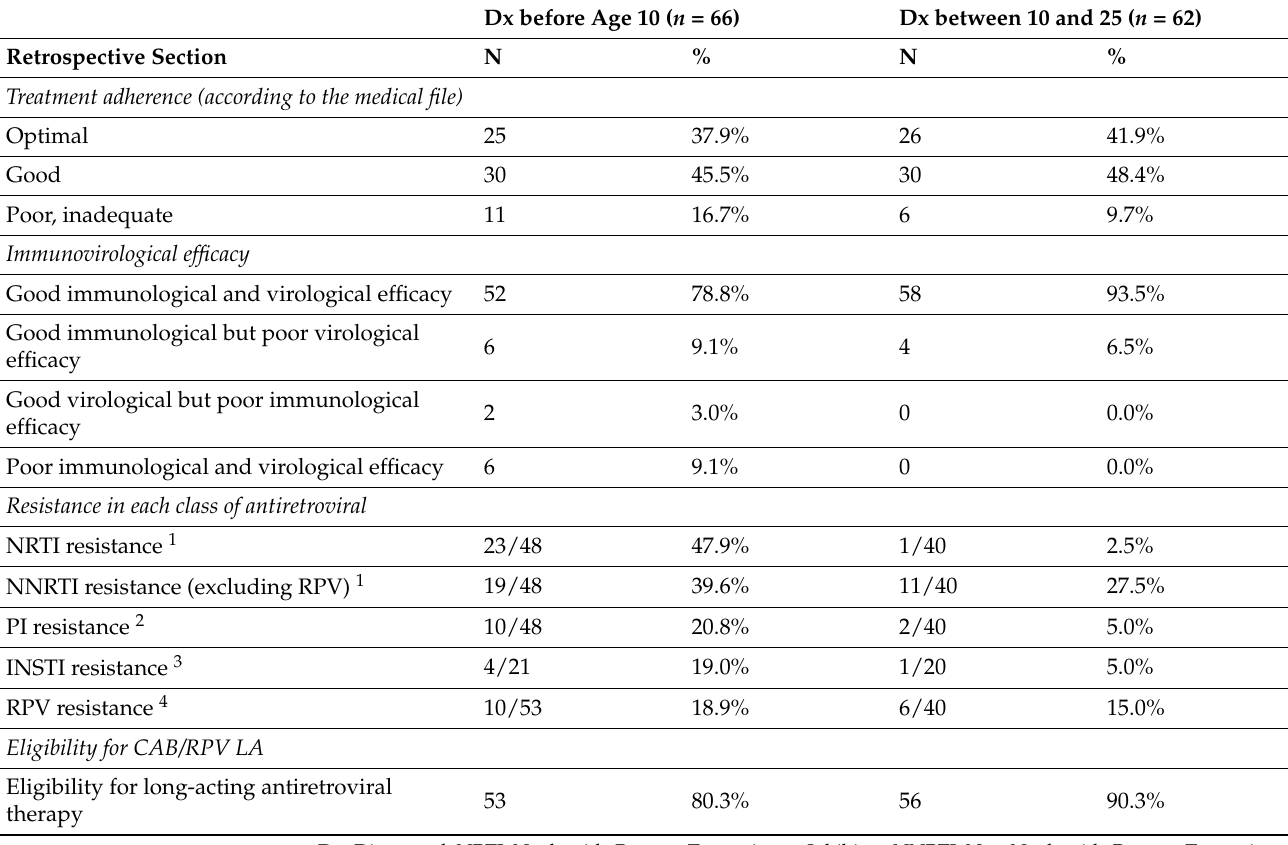
Table 2. Comparative data for the retrospective